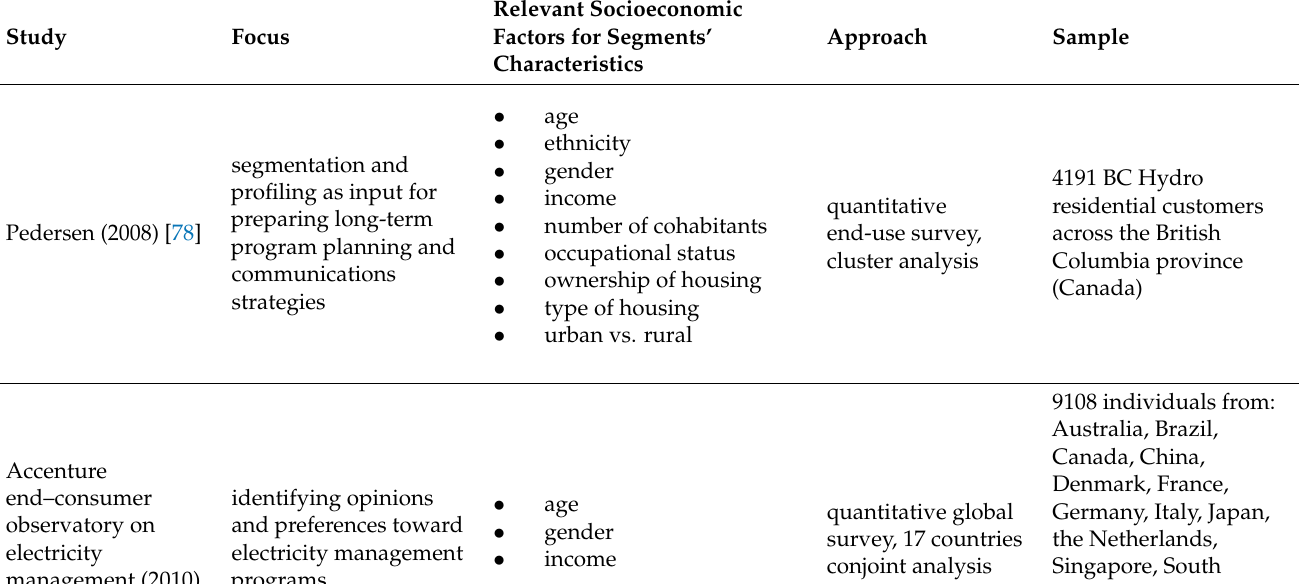
Table 1. Overview of selected energy consumer segmentations with an indication of socioeconomic factors particularly relevant to segment